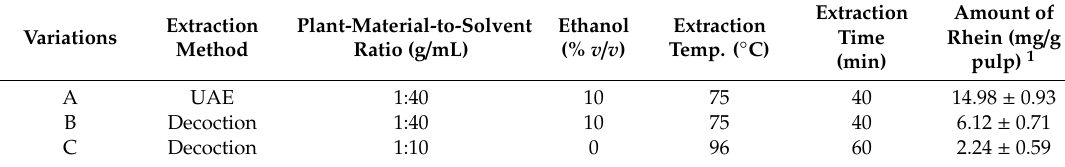
Table 3. The conditions and results of the di ff erent extraction